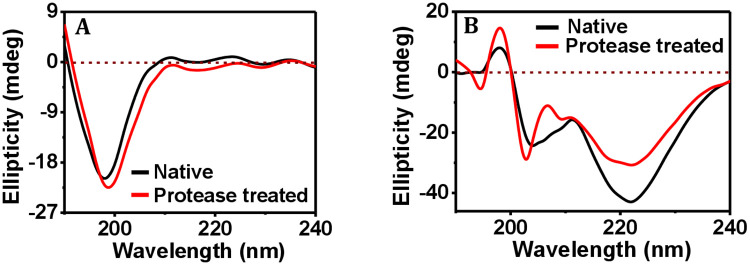
Effect of bacterial protease addition on the secondary structure of proteins.Representative far UV-CD spectra of (A) collagen, and (B) ferritin, before and after addition of bacterial protease.